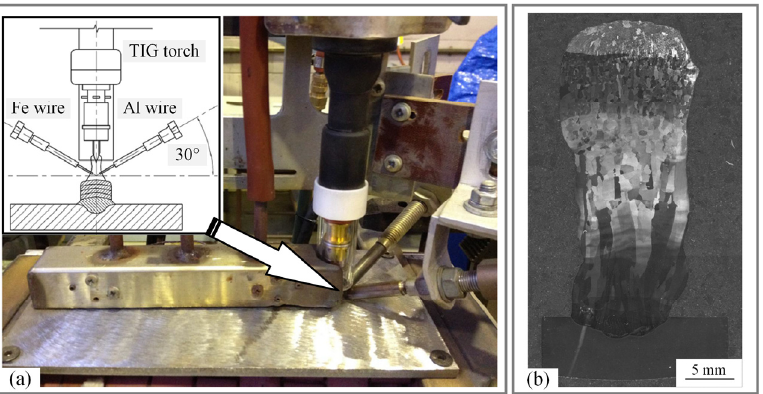
Figure 14. ( a ) Schematic of WAAM system, ( b ) Macrostructure of the cross section of FGMs [71].